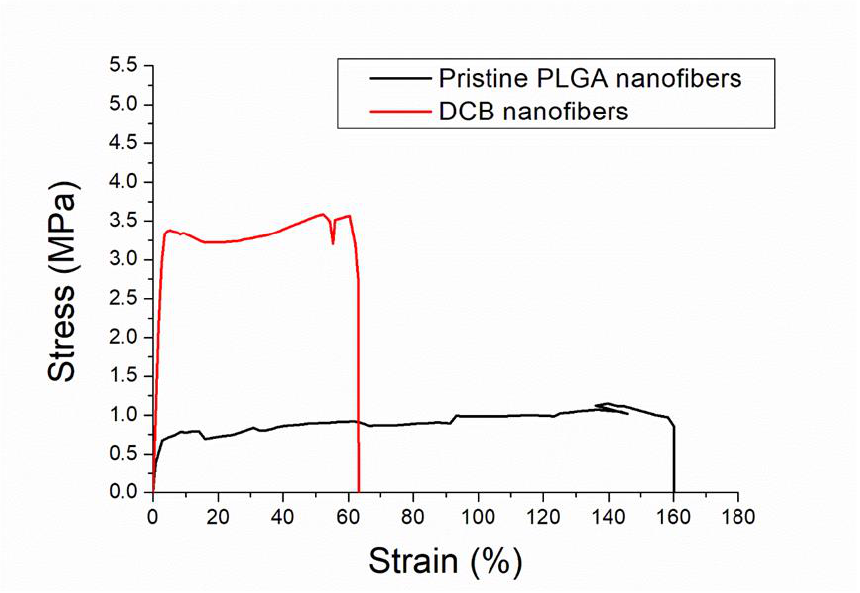
Figure 3. Stress – strain curves of pristine PLGA and DCB – PLGA-composite nanofibers. Figure 3. Stress–strain curves of pristine PLGA and DCB–PLGA-composite